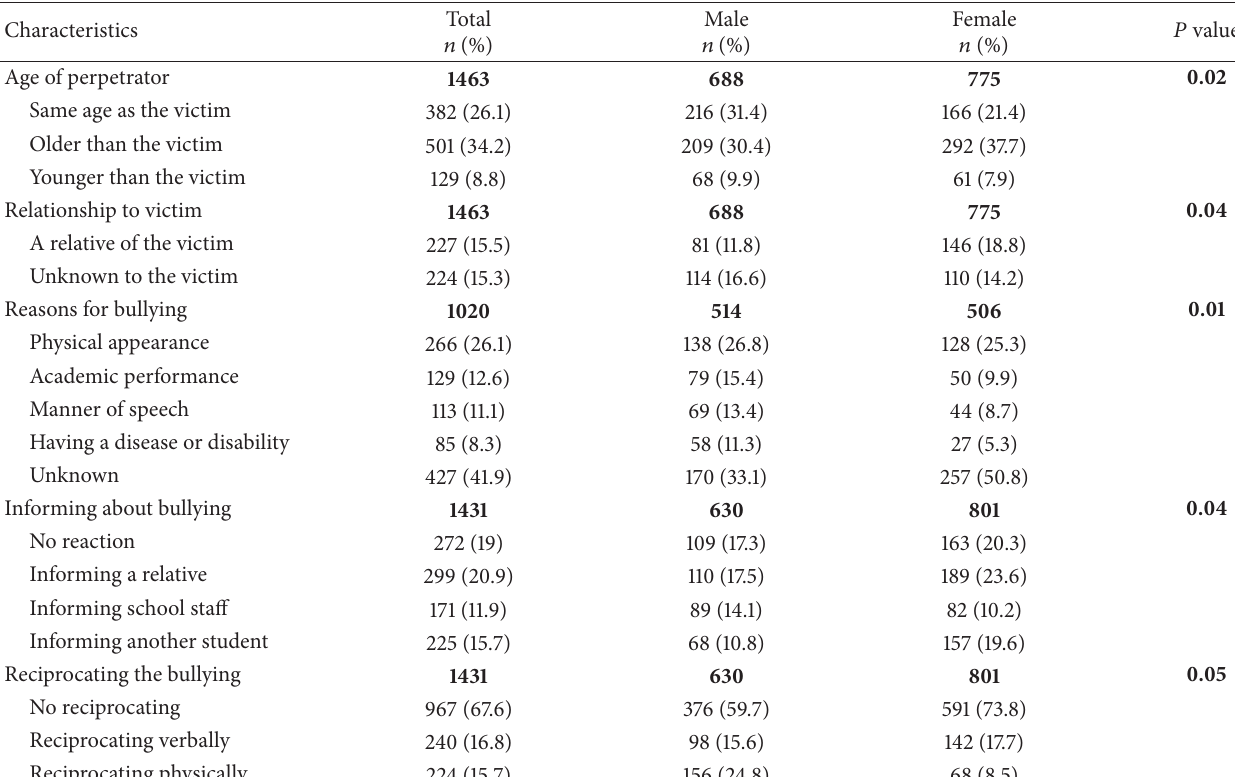
Table 3: Characteristics of bullying perpetrators and the reactions of the victims towards bullying incidents among school pupils in a 12- month period stratified by gender, Oman, 2007.